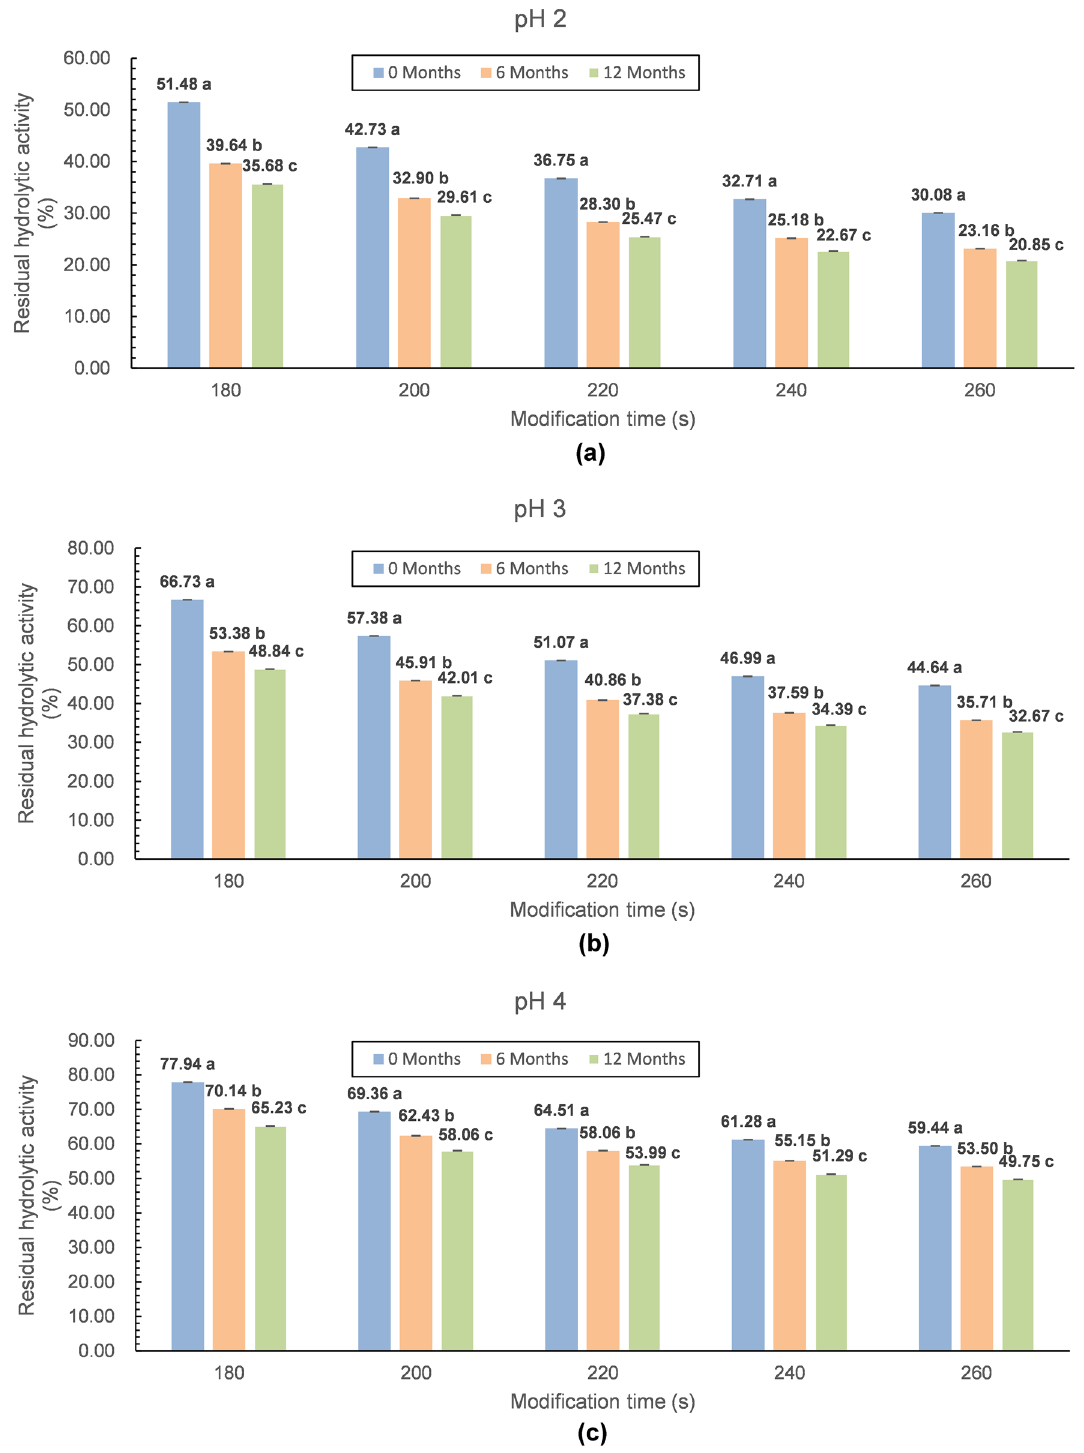
Figure 3. Graphical interpretation of the storage changes of the hydrolytic activity of microwave-modified lysozyme preparations ( a —pH 2, b —pH 3, c —pH 4). Storage times: 0, 6, and 12 months. Time of modification: 180, 200, 220, 240, and 260 s. ( a-c Different letters on the bars denote a significant difference in the means at p ≤ 0.05—separately considered for each modification